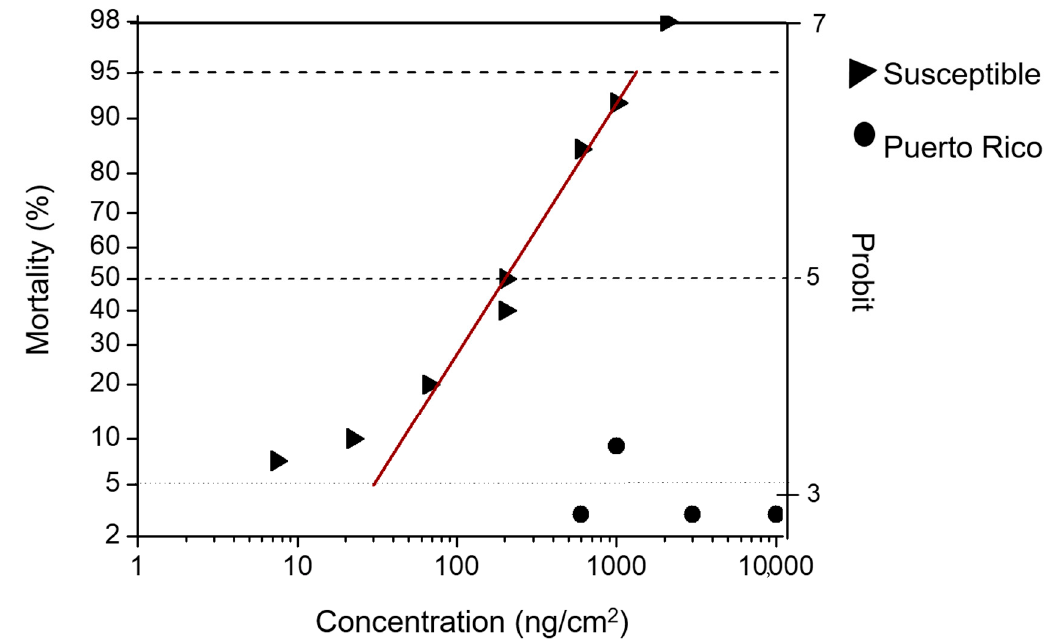
Figure 1. Log concentration-mortality in diet-overlay bioassays to Cry1F. The fall armyworm susceptible laboratory colony (triangles) versus a fall armyworm field population collected in Puerto Rico (circles).